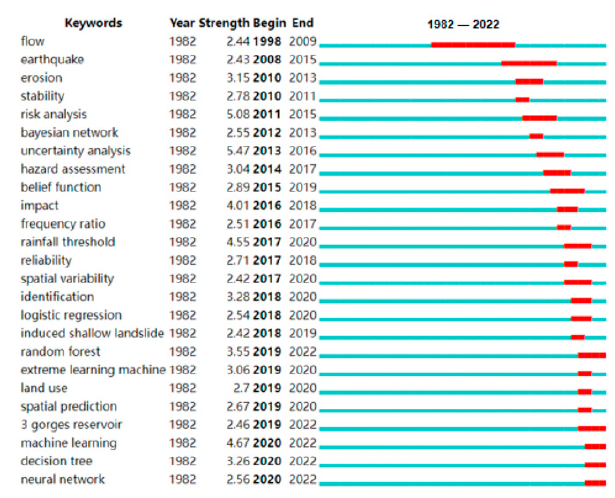
Figure 11. Keyword mutation analysis.